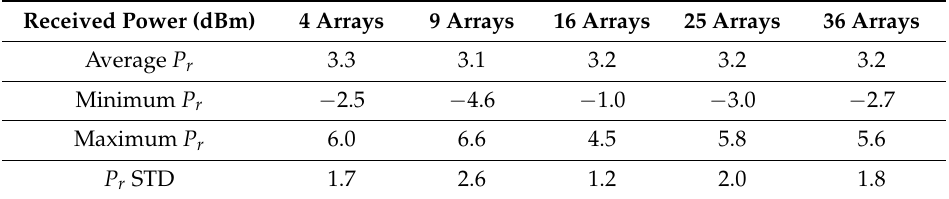
Table 8. Power received at ∅ 1/2 = 30 ◦